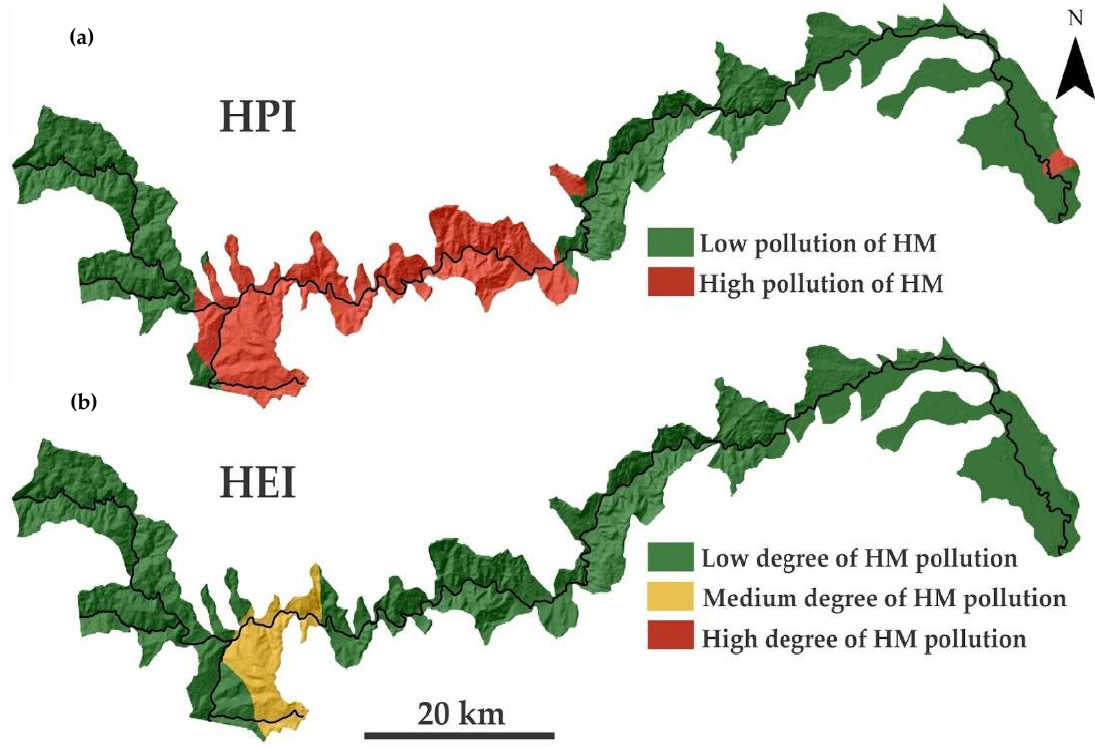
Figure 7. Spatial variation of heavy metal pollution index HPI ( a ) and heavy metal evaluation index HEI ( b ).